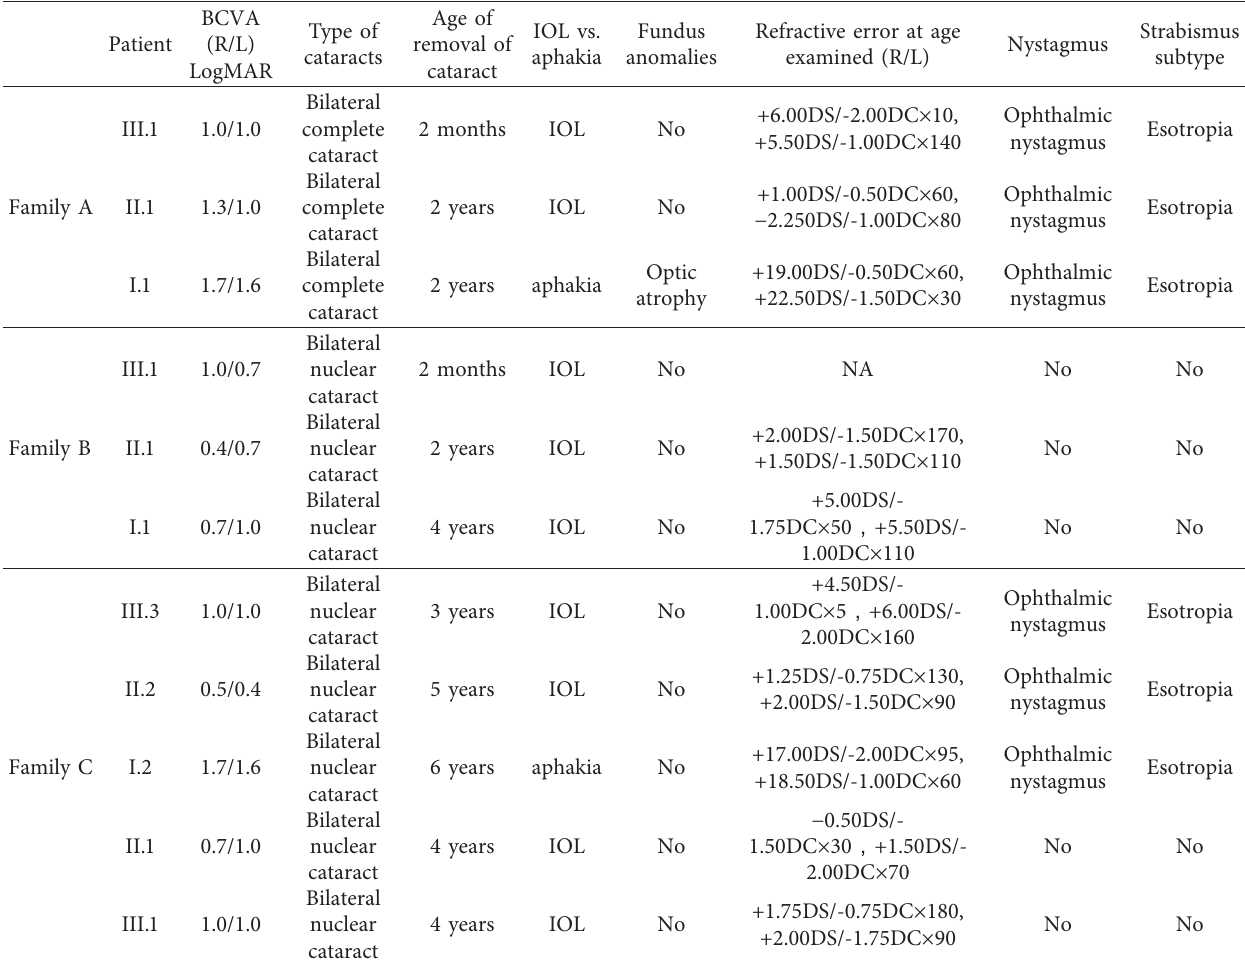
BCVA: best-corrected visual acuity. The best-corrected visual acuity was measured and calculated with the EDTRS visual acuity chart and represented with logMAR. Snellen equivalent is shown in the text. Bilateral nuclear cataract in family B has more opacity in the lens nucleus, while bilateral nuclear cataract in family A has less opacity. IOL: intraocular lens. NA: not acquired. NO: not found; R: right; L: